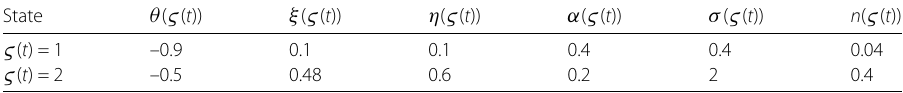
Table 2 Parameter values under finite regime switching of model (4) State θ ( ς ( t )) ξ ( ς ( t )) η ( ς ( t )) α ( ς ( t )) σ ( ς ( t )) n ( ς ( t )) ς ( t ) = 1 –0.9